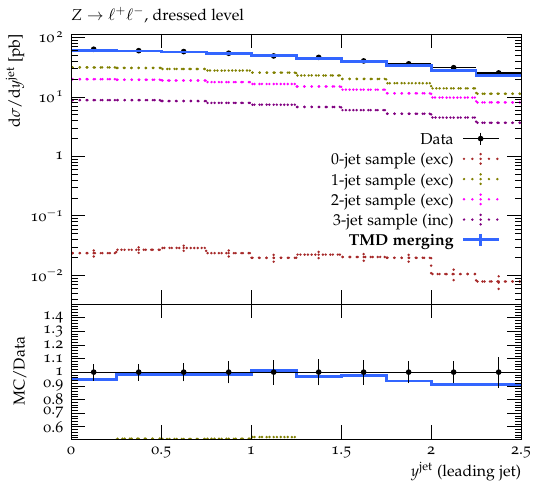
Figure 19 . Leading jet rapidity distribution for Z + jets events. Experimental measurements by √ ATLAS [91] at s = 13 TeV are compared to predictions using the TMD merging calculation. Separate contributions from the different jet samples are shown. All the jet multiplicities are obtained in exclusive (exc) mode except for the highest multiplicity which is calculated in inclusive (inc)